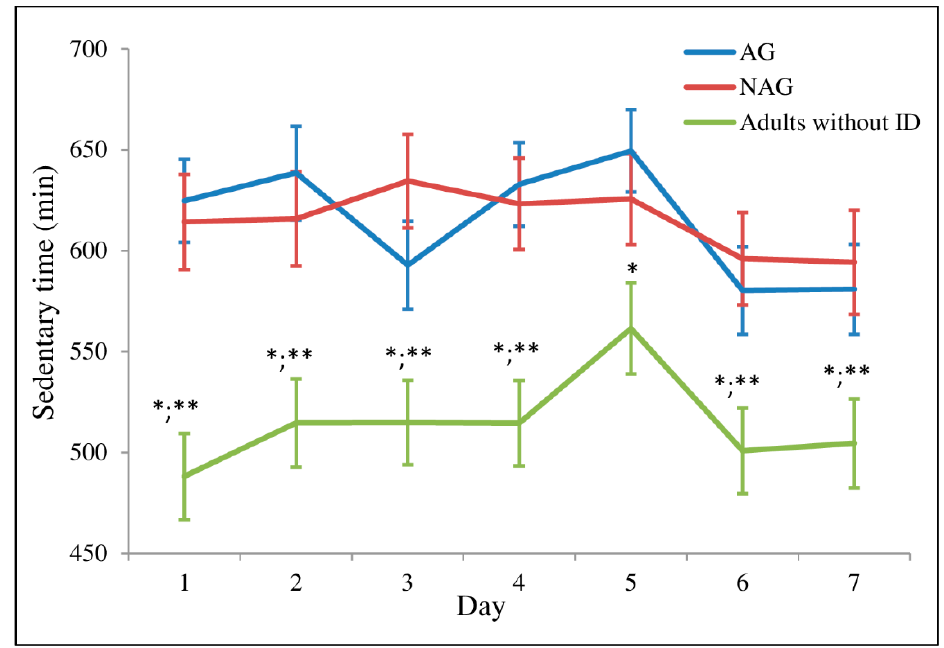
Figure 1. Time spent in sedentary time throughout the week. 1 (Monday); 2 (Tuesday); 3 (Wednesday); 4 (Thursday); 5 (Friday); 6 (Saturday); 7 (Sunday). Values are means (standard error); n = 35 for AG (active group); n = 28 for NAG (non-active group); n = 31 for adults without ID. * Significant difference ( p ≤ 0.05) between adults without ID vs. AG; ** Significant difference ( p ≤ 0.05) between adults without ID vs. NAG.